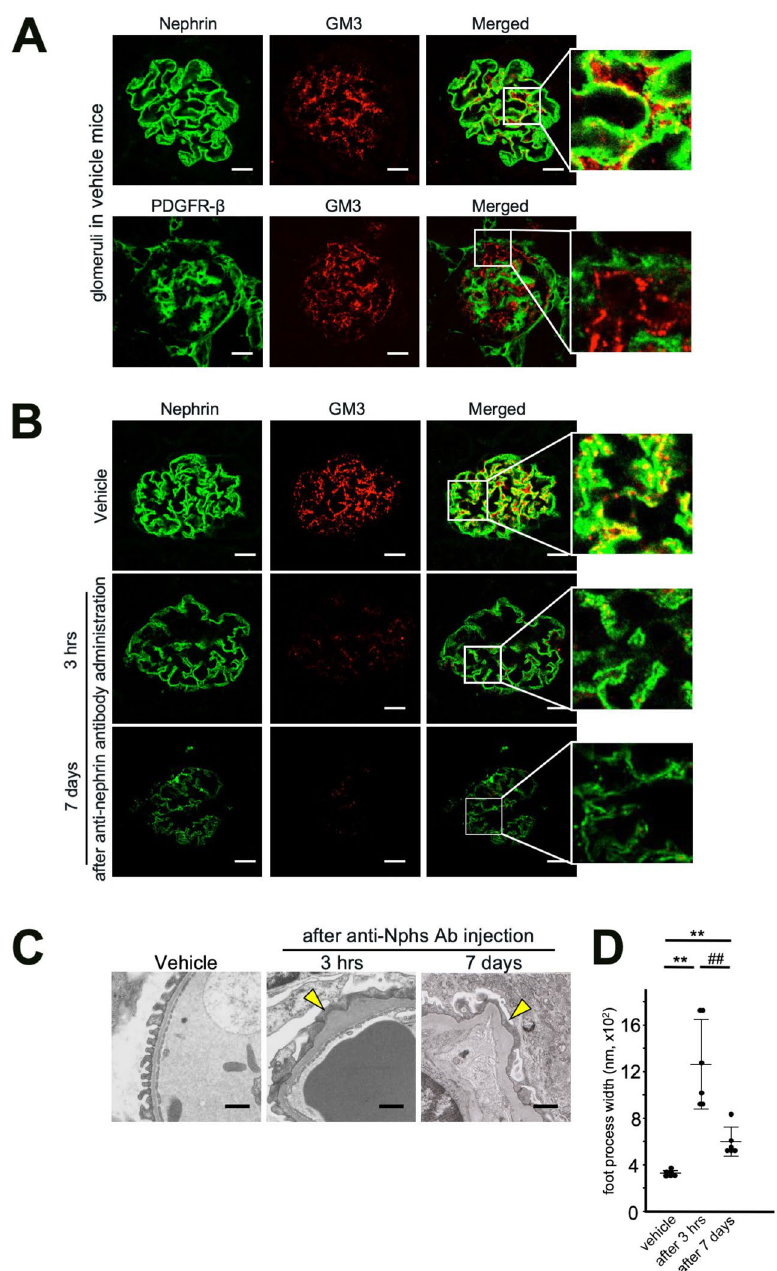
Figure 1. Localization of Nephrin, PDGFR-β and GM3 in glomeruli and the effect of anti-nephrin antibody on the podocyte foot process. ( A ) Immunofluorescence staining images of glomeruli in vehicle mice. Nephrin, or PDGFR-β and GM3 merged florescence images of the glomeruli of vehicle mice. Scale bars: 20 µm. Nephrin (green), or PDGFR-β (green) and GM3 (red) merged areas (yellow) highlighted in enlarged images. ( B ) Immunofluorescence staining images of glomeruli in 1.5 mg of anti-nephrin antibody (anti-Nphs Ab)-induced podocytopathy mice. Scale bars: 20 µm. Nephrin (green) and GM3 (red) merged areas (yellow) highlighted in enlarged images. ( C ) Transmission electron microscopy images of podocyte foot processes in vehicle mice and anti-Nphs Ab-induced podocytopathy mice. Yellow arrowheads showing areas of foot process effacement. Scale bars: 10 µm. ( D ) Scatter diagram showing quantification of foot process effacement. ** P < 0.01 vs. vehicle, ## P < 0.01 vs. 3 h after antibody administration. Statistical analyses were performed from mice (n = 6) in each